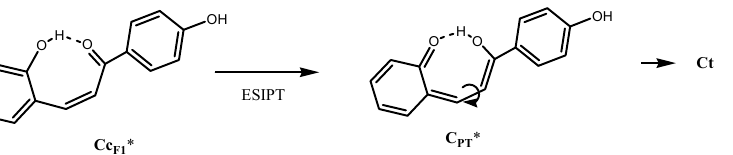
Figure 10. Intra-molecular proton transfer reaction in the excited states (ESIPT) can lead to easier isomerization to trans -chalcone.